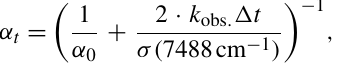
Figure 4. Second-order decay of the CH 3 O 2 absorption coefficient at 7488cm − 1 monitored by CRDS. Experiment carried out at 295K and 100mbar of synthetic air; [CH 4 ] 0 = 2 . 4 × 10 16 moleculecm − 3 and [Cl 2 ] 0 = 1 . 0 × 10 15 moleculecm − 3 . At time 2205s the photol- ysis lamps were turned off (time t 0 ). Fitting Eq. (8) to the data (red line) gave σ (7488cm − 1 ) = ( 1 . 47 ± 0 . 07 ) × 10 − 20 cm 2 molecule − 1 . A fit including the wall loss rate, k loss (Eq. 9), is shown by the blue dashed line and resulted in σ( 7488cm − 1 ) = ( 1 . 50 ± 0 . 07 ) × 10 − 20 cm 2 molecule − 1 . The error limits are statistical errors at the 1 σ